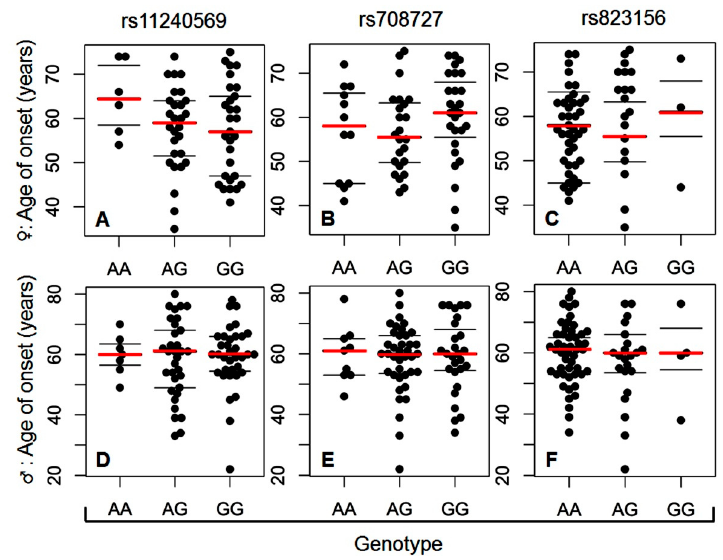
Figure 3. Correlation between age of onset of idiopathic PD and the particular genotypes at each tested A1 SNP in the subgroup of female PD patients ( A–C ; ( A ) rs11240569, ( B ) rs708727, ( C ) rs823156; N = 63, 3 out of 66 patients in subcohort of PD females have been excluded from the correlation due to discrepancies about the age of PD onset in their documentation) and the subgroup of male PD patients ( D–F ; ( D ) rs11240569, ( E ) rs708727, ( F ) rs823156; N = 75, 9 out of 84 patients in subcohort of PD males have been excluded from the correlation due to discrepancies about the age of PD onset in their documentation).